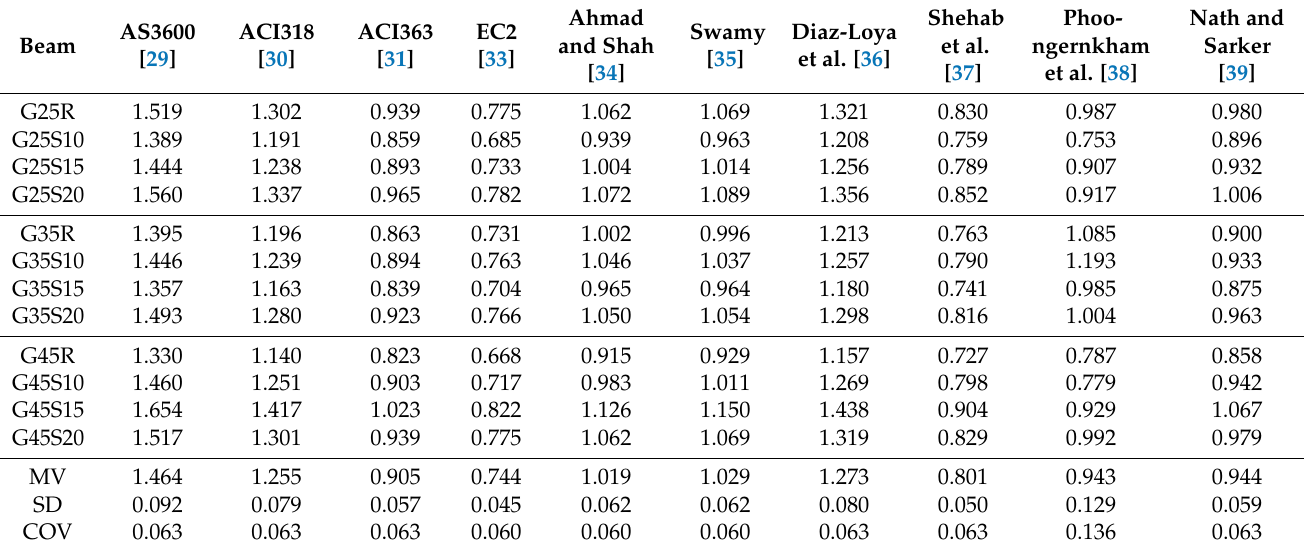
Table 4. Comparison of experimental-to-predicted cracking moment ratios ( M cr,exp /M cr,pred